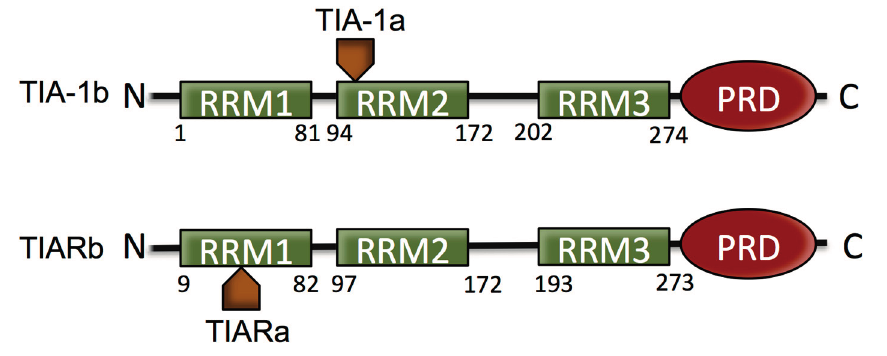
Figure 1. Schematic of the domain structure of T cell restricted intracellular antigen (TIA) protein isoforms. TIA proteins consist of three RNA recognition motifs (RRMs) that provide RNA/DNA binding specificity and a Q-rich prion-related domain (PRD) domain, involved in stress granule (SG) formation. The two isoforms of both proteins that form as a result of alternative splicing are